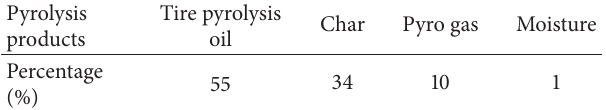
Table 1: Percentage of pyrolysis products.